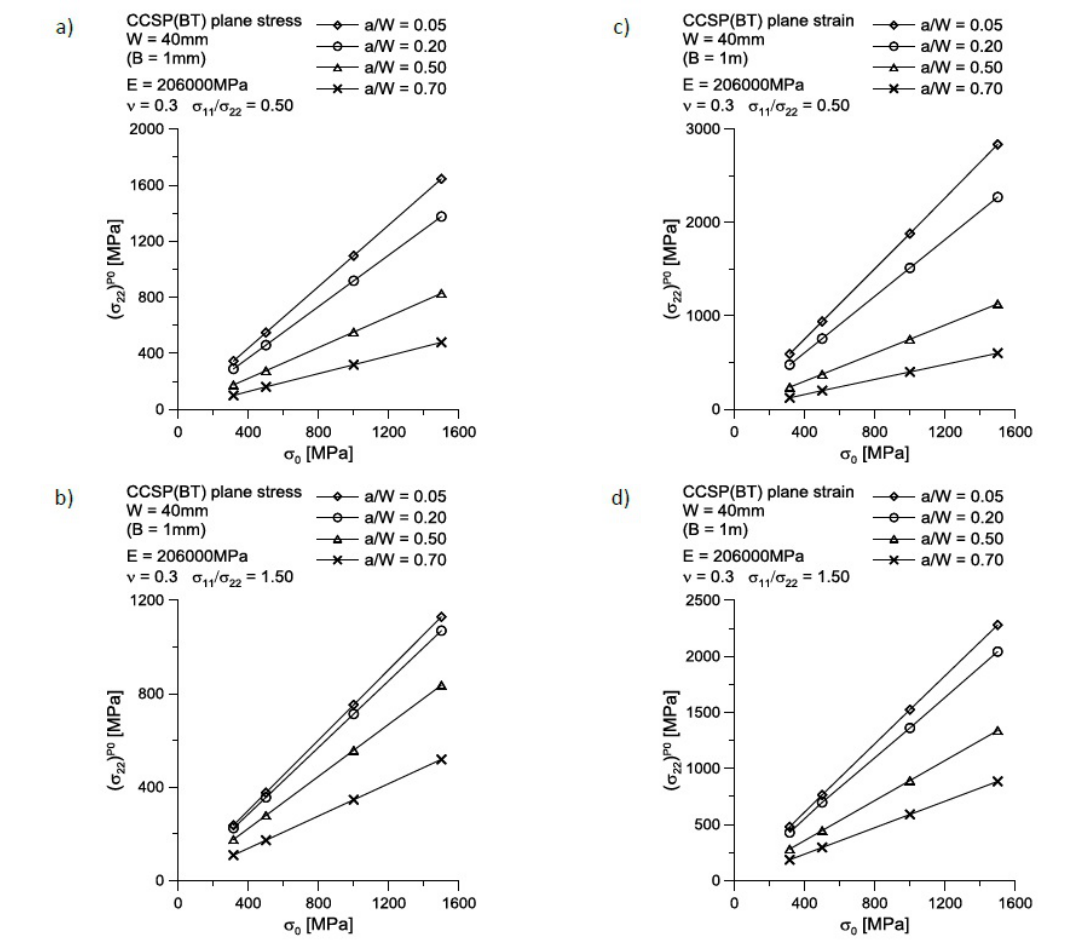
Figure 7: Limit load ( σ 22 ) P 0 vs. yield strength σ 0 vs. for the plane stress state (a, b) and the plane strain state (c,